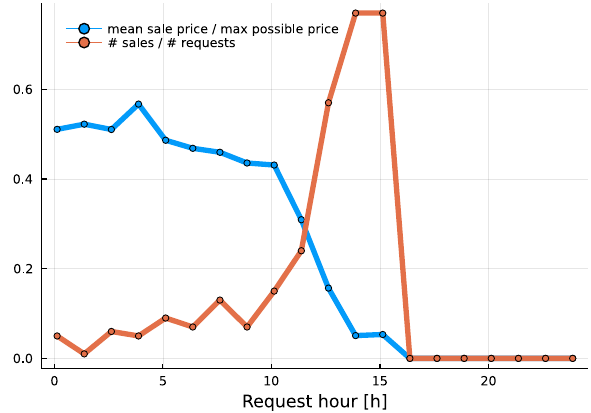
Figure 8. Pricing response of MCTS to a state s = ( c 0 ,1, d ) (i.e., full initial capacity and first timestep) and a request d for an hour-long charging session starting at 16:00. The plot shows average MCTS prices divided by a maximum possible price ( max ( A ) ) and average number of accepted price offers by 100 randomly sampled user